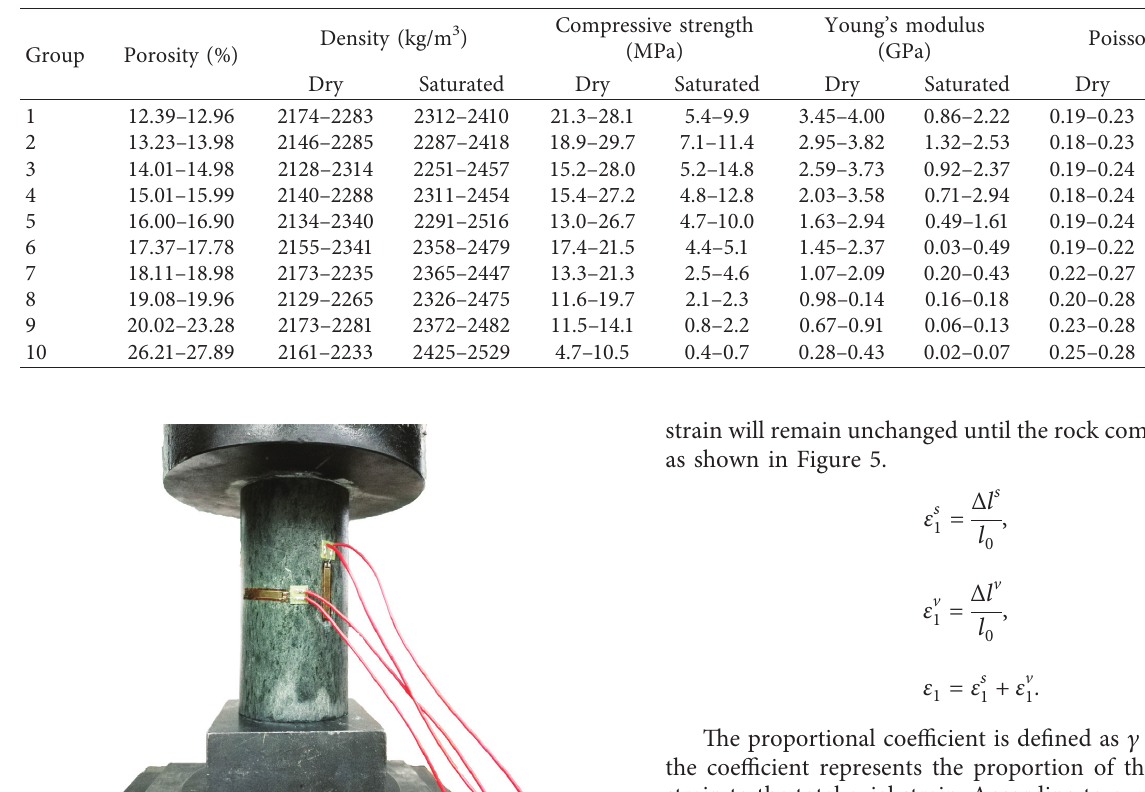
Table 1: Test data of sandstone samples.